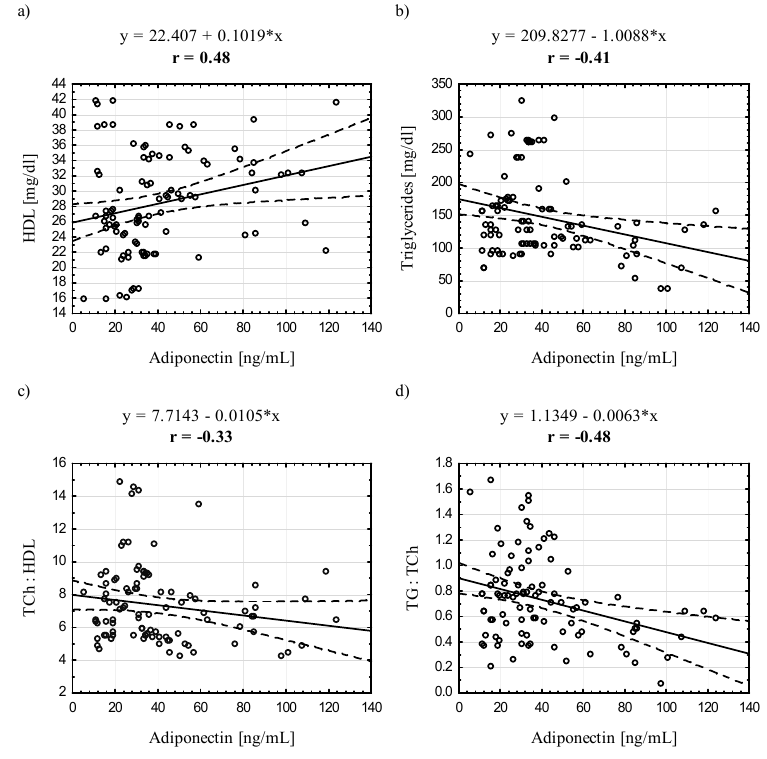
Figure 2. Scatter plots for the correlation ( p < 0.05) between adiponectin and selected blood lipid profile